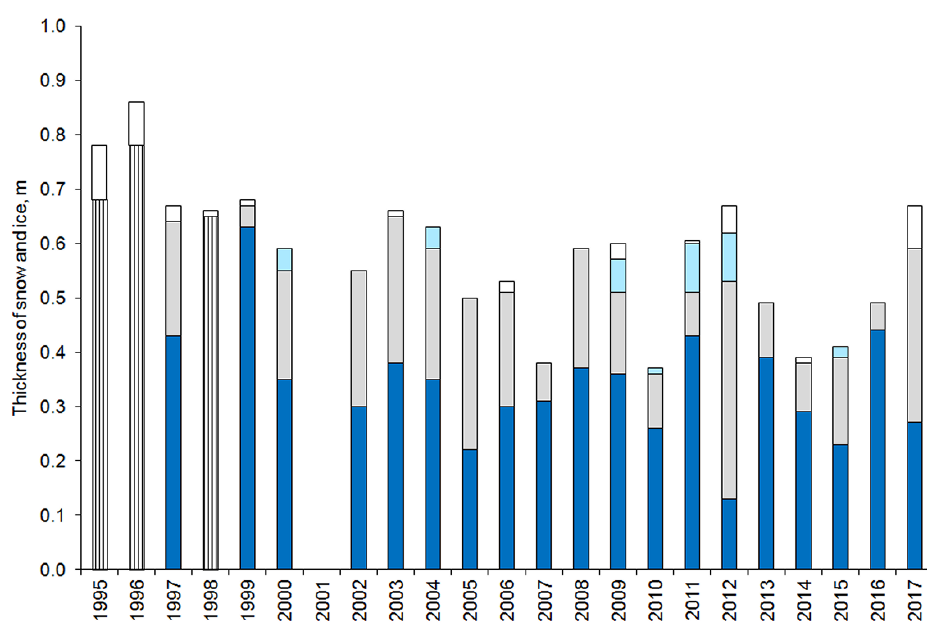
Figure 3. The spatial average over all stations of thickness of snow (white rectangle), total ice (vertical lines), slush (sky blue), white ice (grey) and congelation ice (dark blue) at the beginning of the radiation measurement period in April in different years.